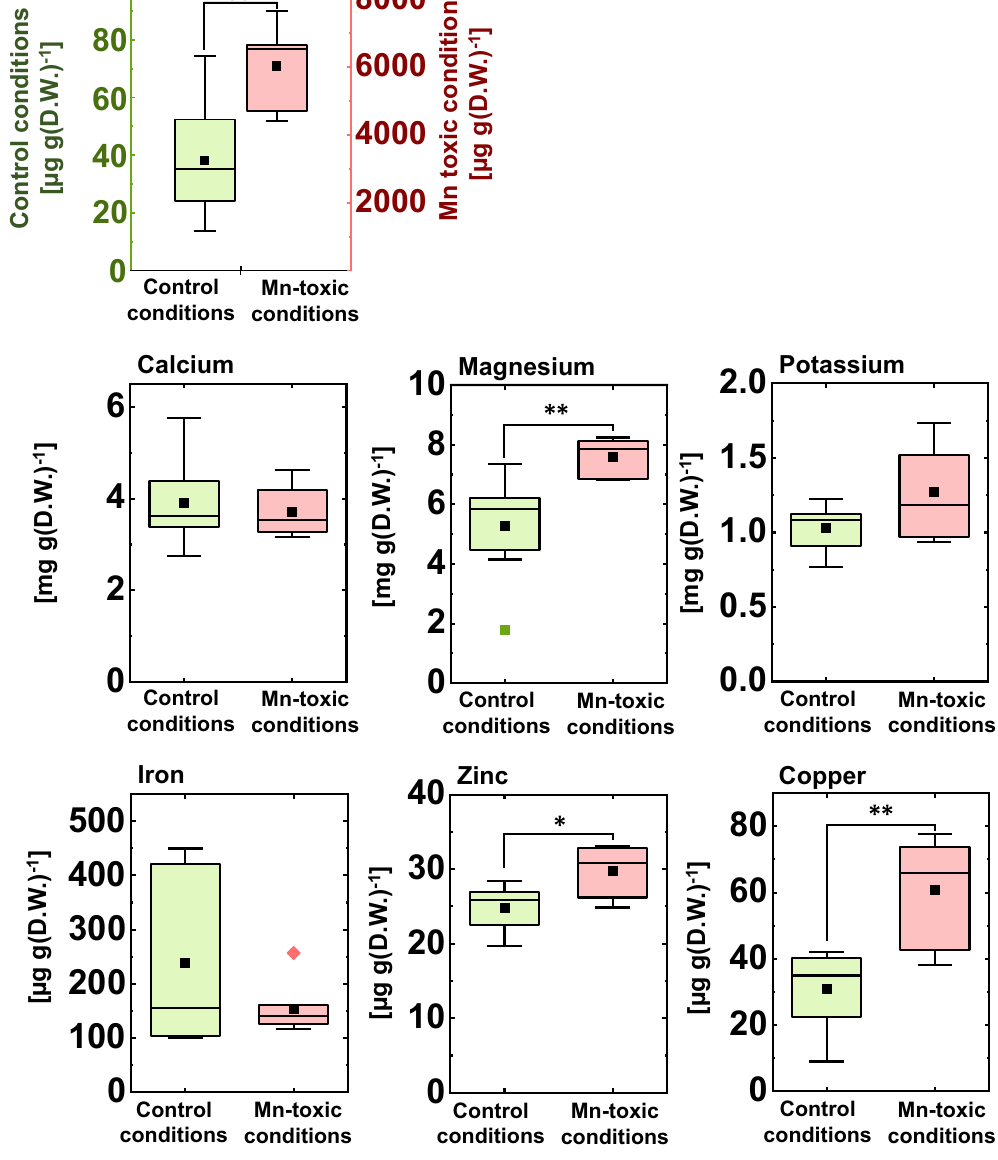
Figure 2. Mineral concentration in the rice leaf blade. Data are shown as box plots obtained by independent biological replicates (control conditions n = 8, Mn-toxic conditions n = 7), black squares indicate the mean value, and bars indicate the range of the maximum or minimum data within a 1.5 × interquartile range (IQR). Green boxes indicate the results of the control conditions, and red boxes indicate those of the Mn-toxic conditions. Asterisks indicate significant differences between the control and Mn-toxic conditions (* p < 0.05, ** p < 0.01, Kruskal–Wallis